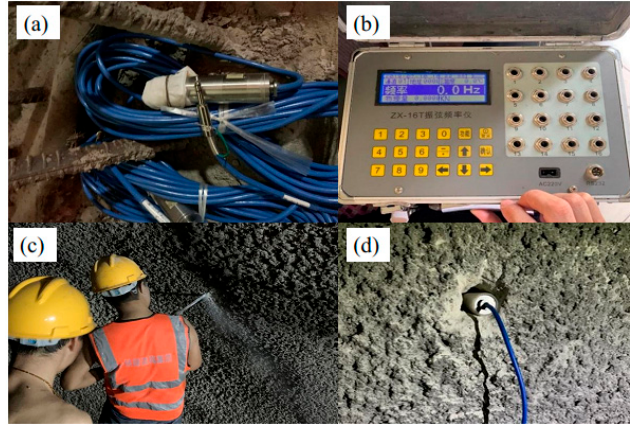
Figure 4. The pore water pressure sensor and field installation drawing: ( a ) pore water pressure sensor; ( b ) data acquisition instrument; ( c ) drill hole; ( d ) layout of the pore water pressure sensor.